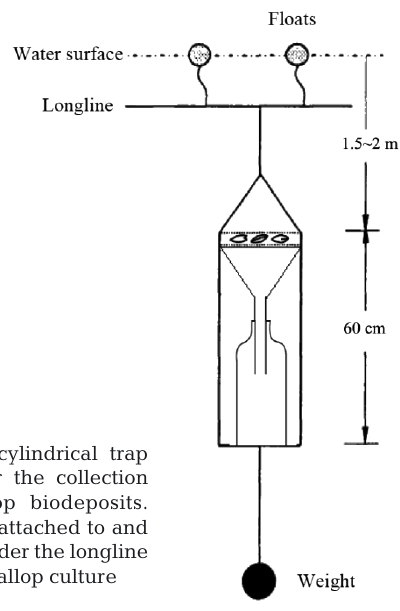
Fig. 2. PVC cylindrical trap developed for the collection of bay scallop biodeposits. The trap was attached to and suspended under the longline used for scallop